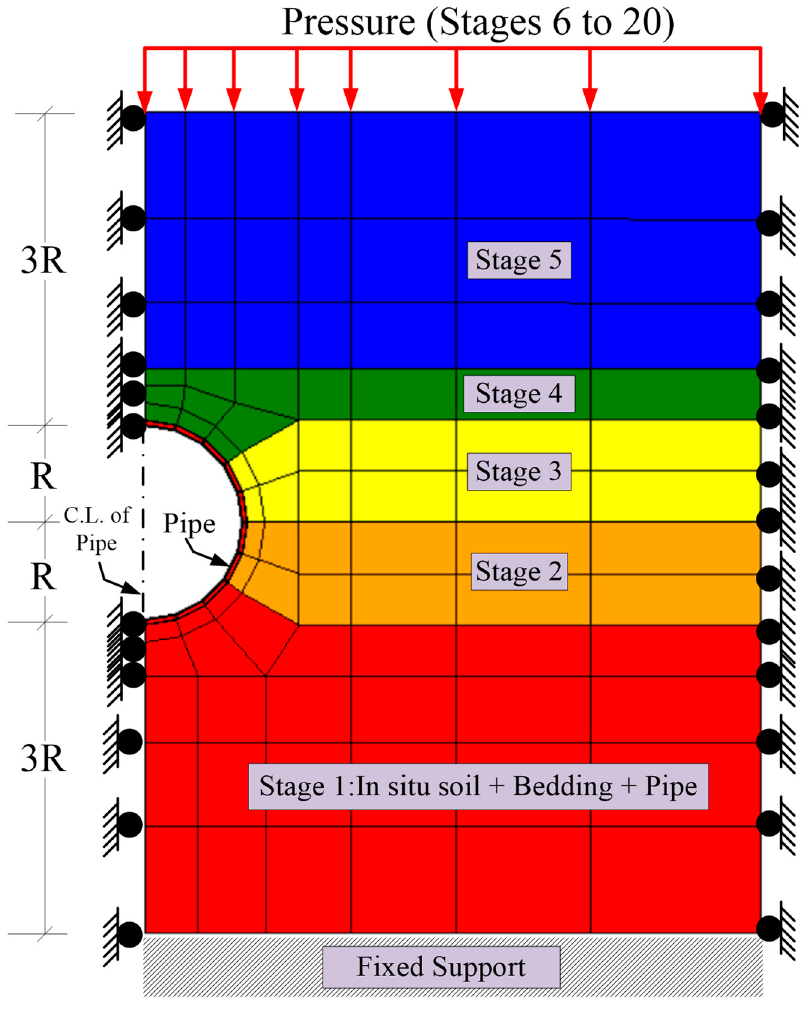
Figure 4. Construction and pressure stages of the FEA